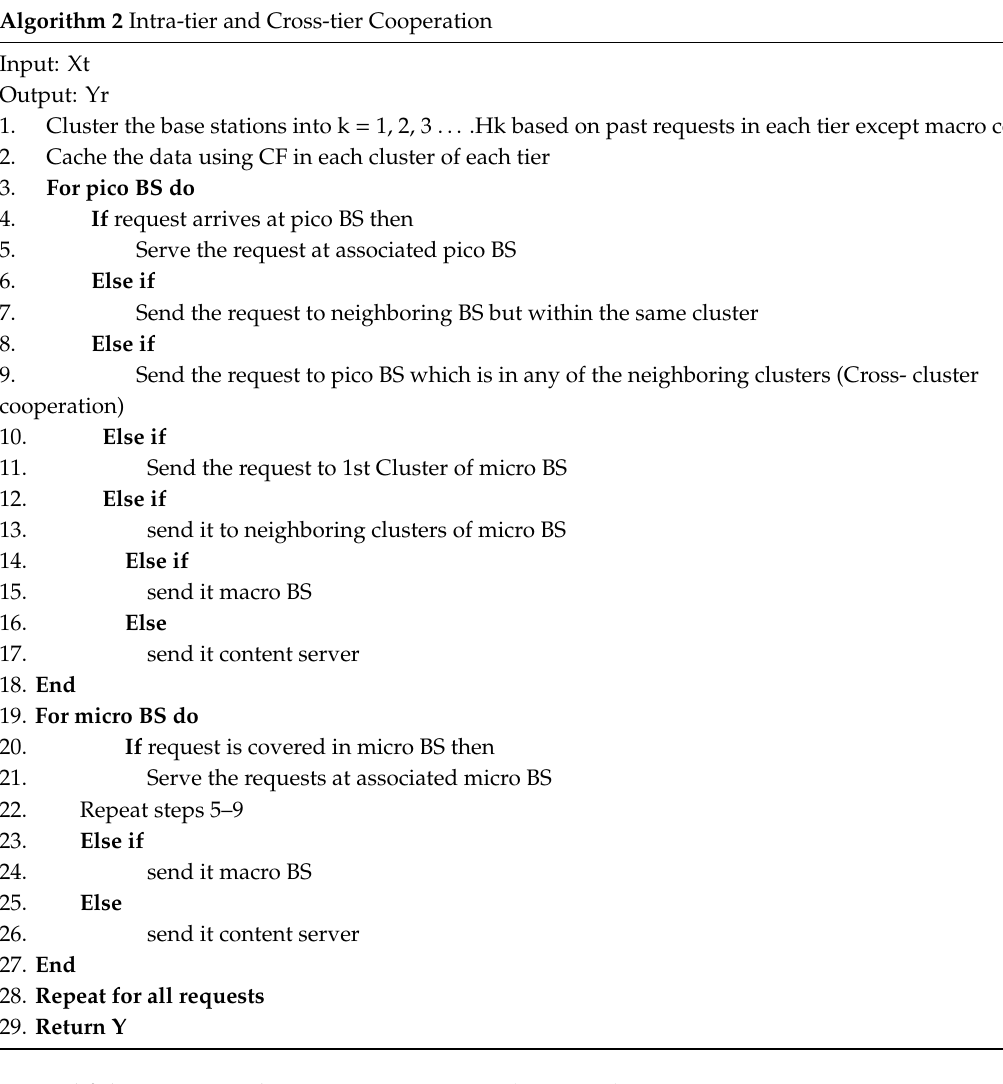
Algorithm 2 Intra-tier and Cross-tier